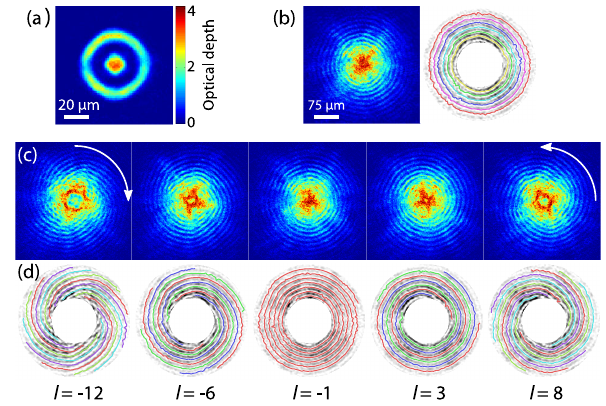
FIG. 1. (a) In situ image of the ring and disk BECs with dimensions shown. (b) Example interferogram after 15 ms TOF (left) when there is no current in the ring, including traces of the azimuthal interference fringes to guide the eye (right). (c) Inter- ferograms for various winding numbers, where the arrow indicates the direction of flow. (d) Traces of the interference fringes to guide the eye and count the number of spiral arms. The extracted winding number is shown below the